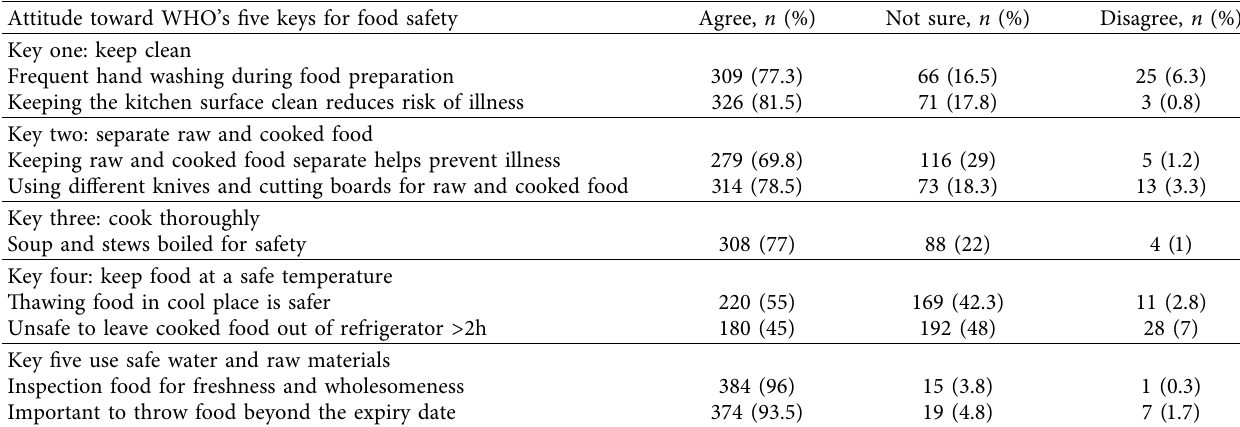
Table 3: Distribution of participants according to the attitude toward the World Health Organization’s five keys for food safety ( n � 400). Attitude toward WHO’s five keys for food